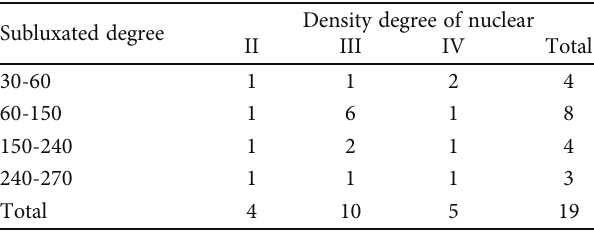
Table 1: The number of cases with di ff erent ranges of crystal dislocation and the number of cases with di ff erent hardness of crystal